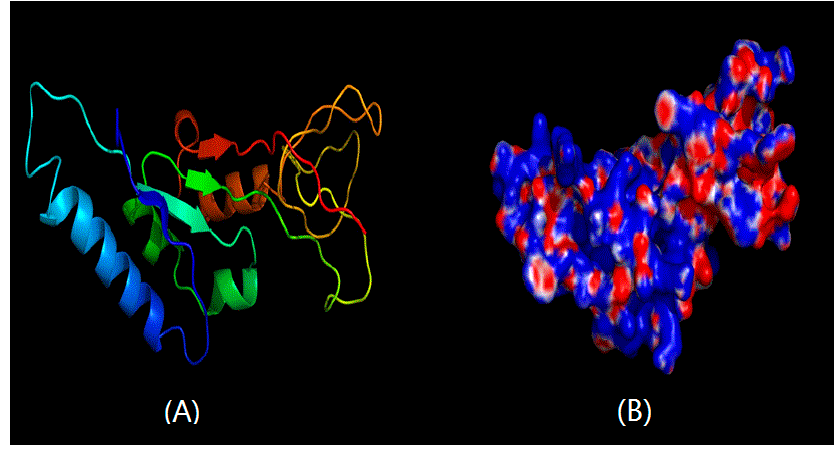
Figure 2. The predicted ribbon-model structure ( A ) and surface ( B ) of CHI 1 chitinase from SYBC-H1.